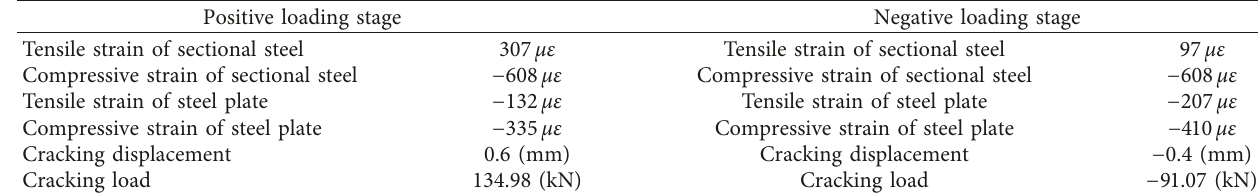
Table 4: Test data of test piece SPRCW-1 in the load control